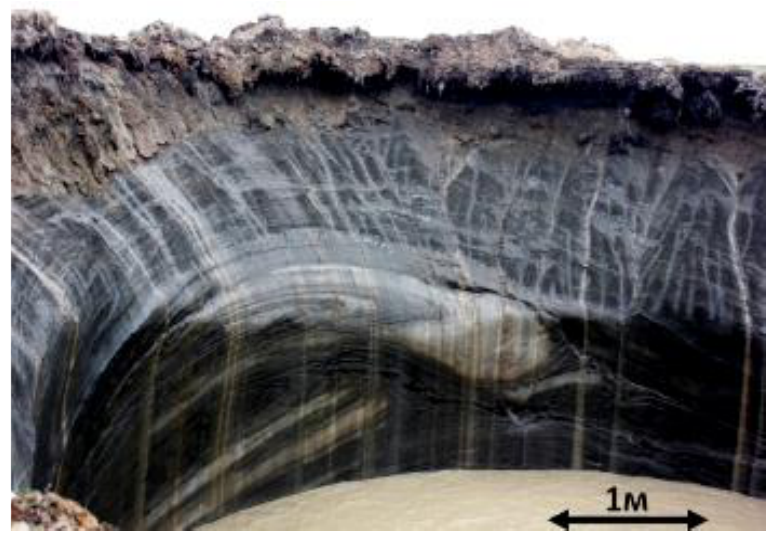
Figure 6. Deformed gas-saturated ice pushed into the layered ice – ground massif. July 2015. Photo credit: A.V. Lupachev.